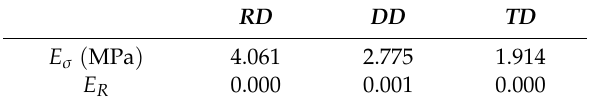
Table 5. RMSE of the fitting procedure in the true stress-strain curves and Lankford coe ffi cients. RD DD